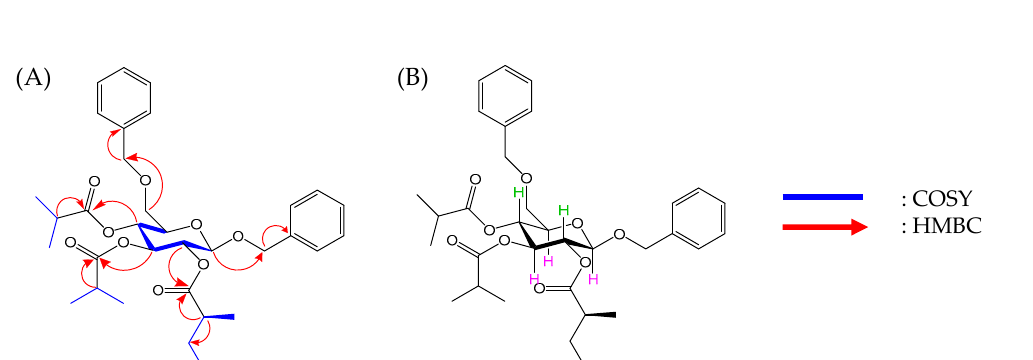
Figure 2. Important resonances of compound 2 ; ( A ) key 1 H- 1 H COSY and HMBC correlations; ( B ) key NOESY interactions observed between protons shown in the same color (pink and green). Table 1. 1 H NMR (500 MHz) and 13 C NMR (126 MHz) spectroscopic data of natural dibenzyl pen-